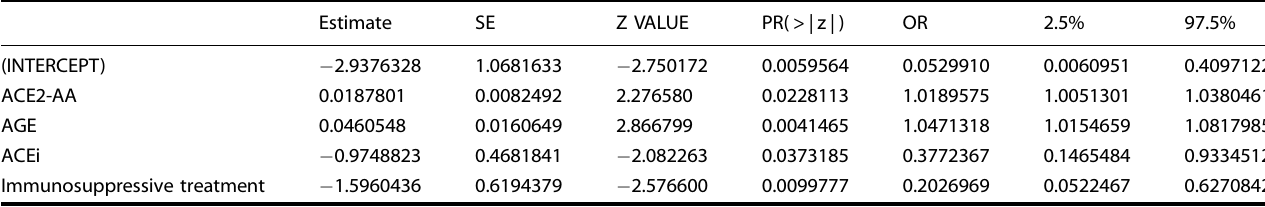
Table 2. Results for the ACE2-AA Multivariate Logistic Regression Model.